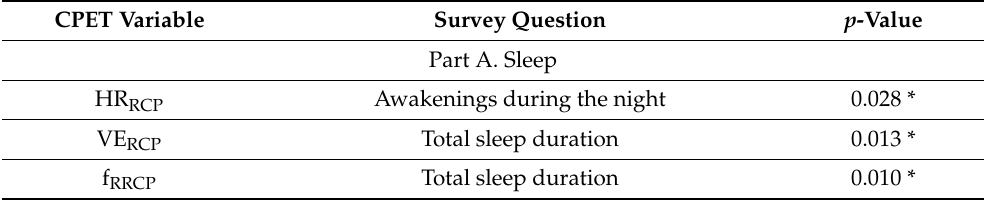
Table 4. Relationships between sleep, mental health, and CPET